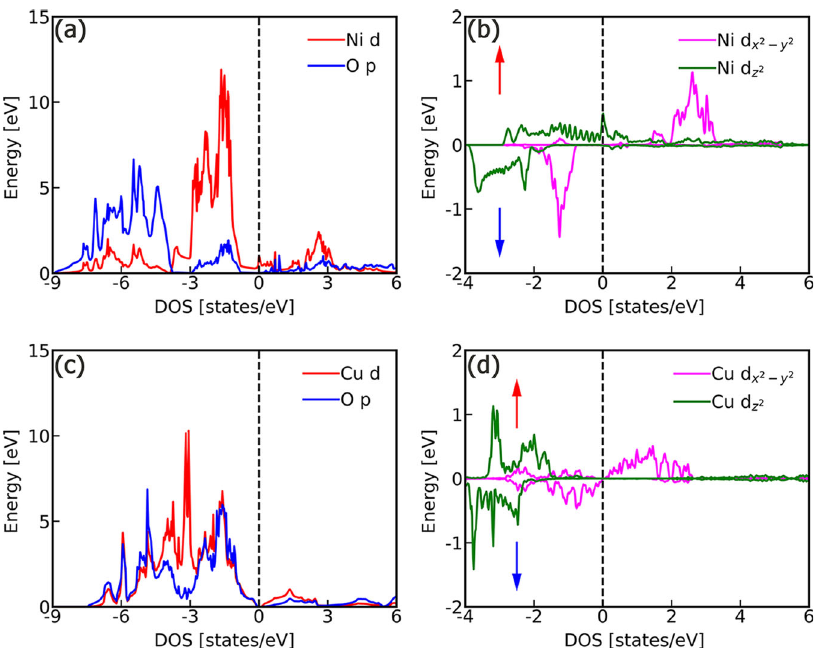
Fig. 7 Comparison the partial density of states (DOS) between C -type antiferromagnetic ( C -AFM) phase of NdNiO 2 and CaCuO 2 . a , b Partial DOSs for various sites and orbitals (see legend) in the C -AFM phase of NdNiO 2 . c , d Same as a , b , except that these panels refer to the C -AFM phase of CaCuO 2